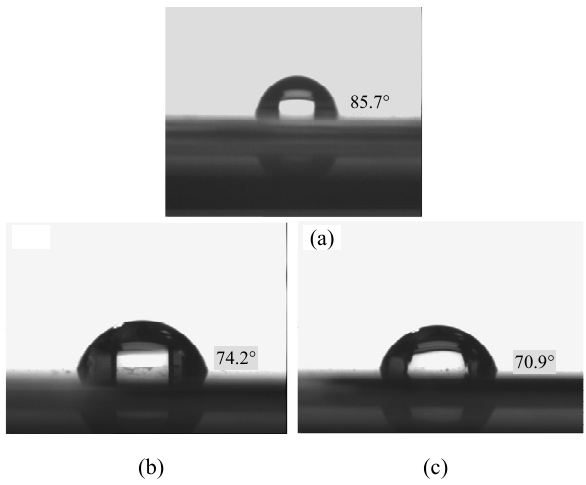
Fig. 6 Contact angle images: (a) unmodified SPR chip surface; (b) MIP and (c) NIP SPR sensors